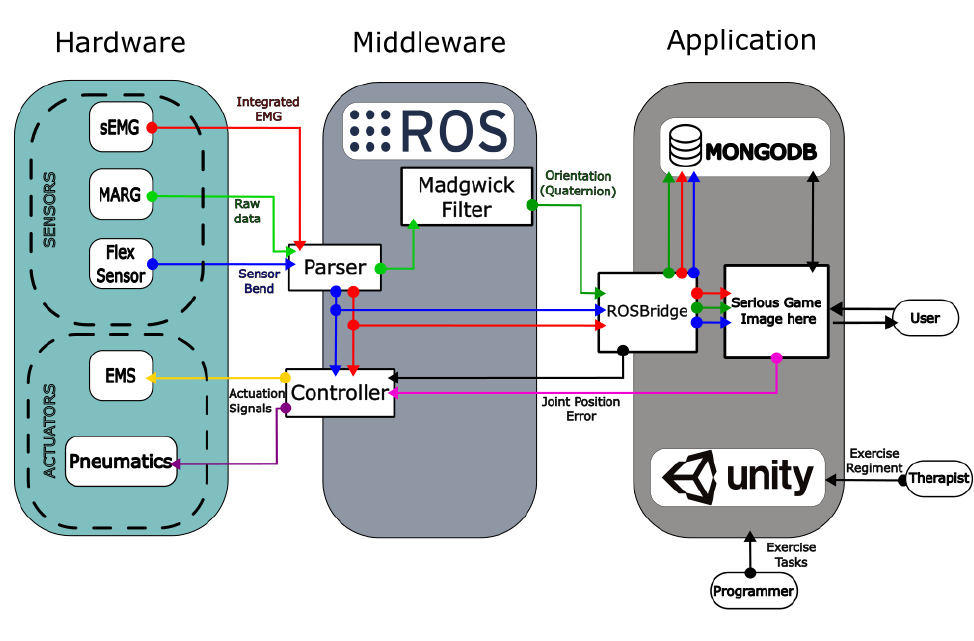
Figure 1. NeuroSuitUp system